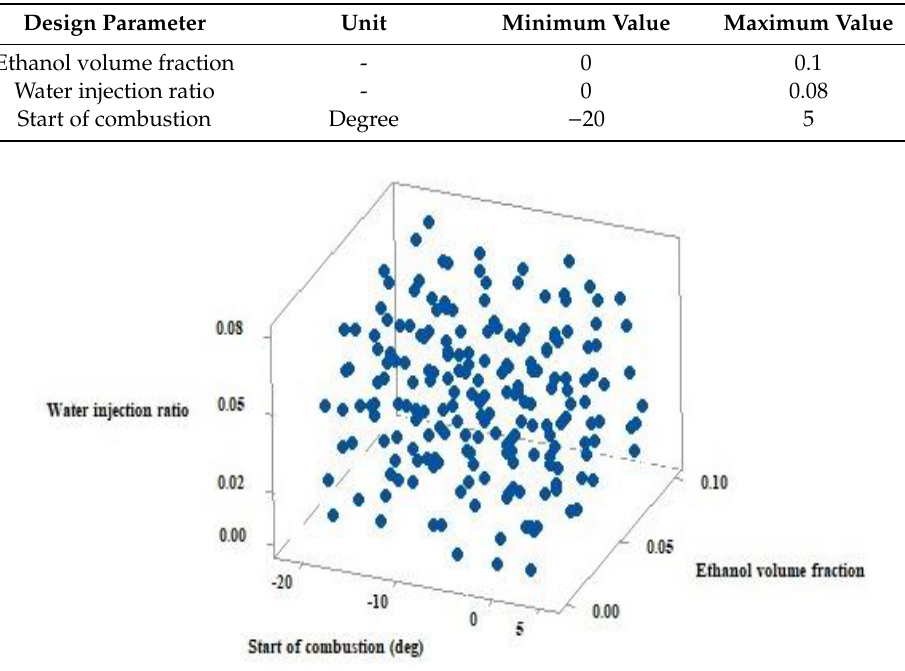
Figure 4. The sampling space and the design points in Latin Hypercube DOE method.